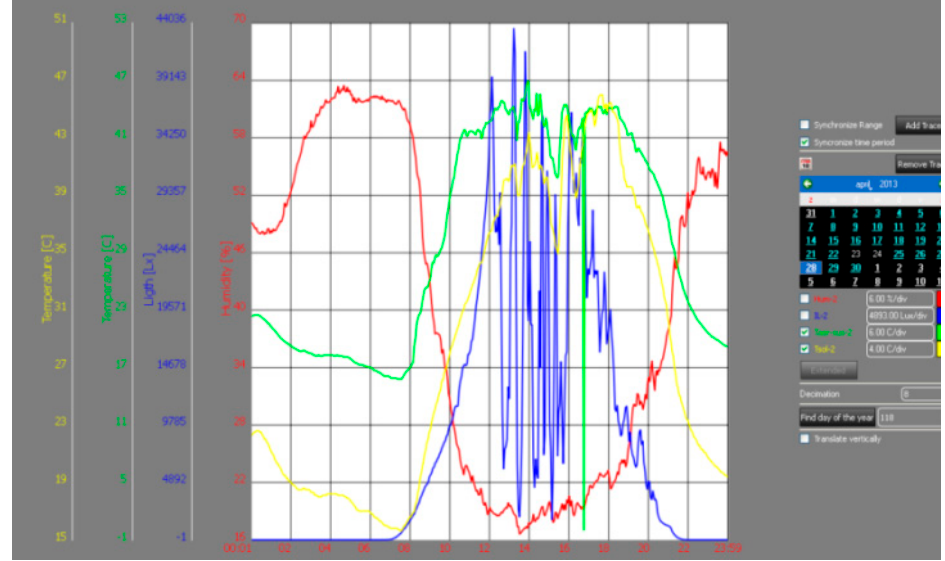
Figure 27. Environmental parameter dynamics monitored in the fourth day of water stress Figure 26. Environmental parameter dynamics monitored in the fourth day of water stress induction.